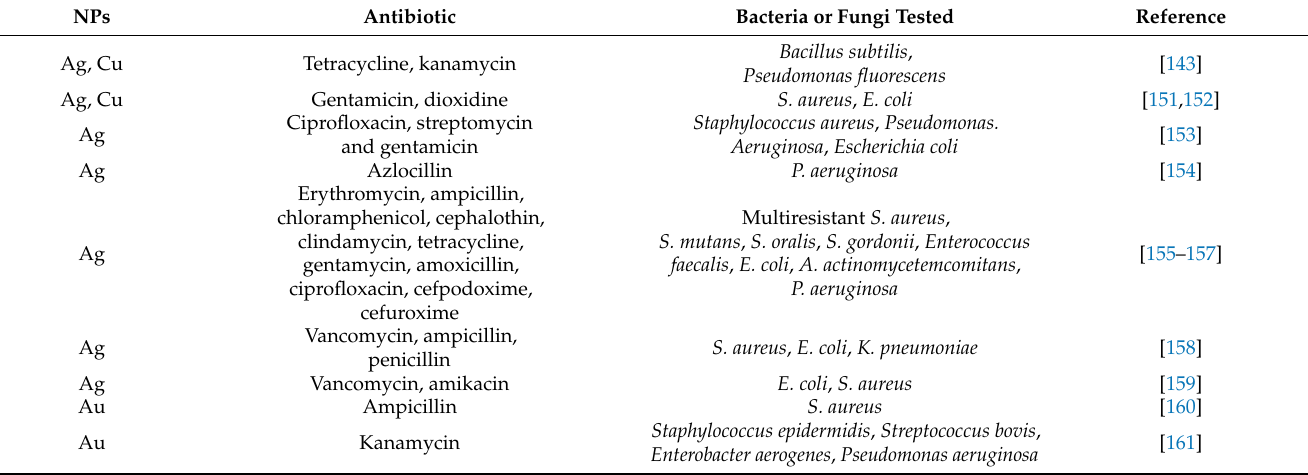
Table 3. Publications devoted to the identification of the synergistic antibacterial effect of antibiotics with INPs against bacterial